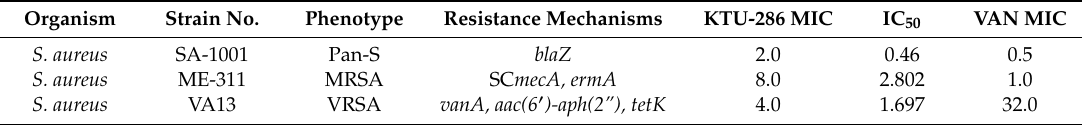
Table 7. Minimal inhibitory concentration (MIC) and IC 50 of KTU-286 and vancomycin among selected representative strains of Staphylococcus aureus harboring genetically defined resistance